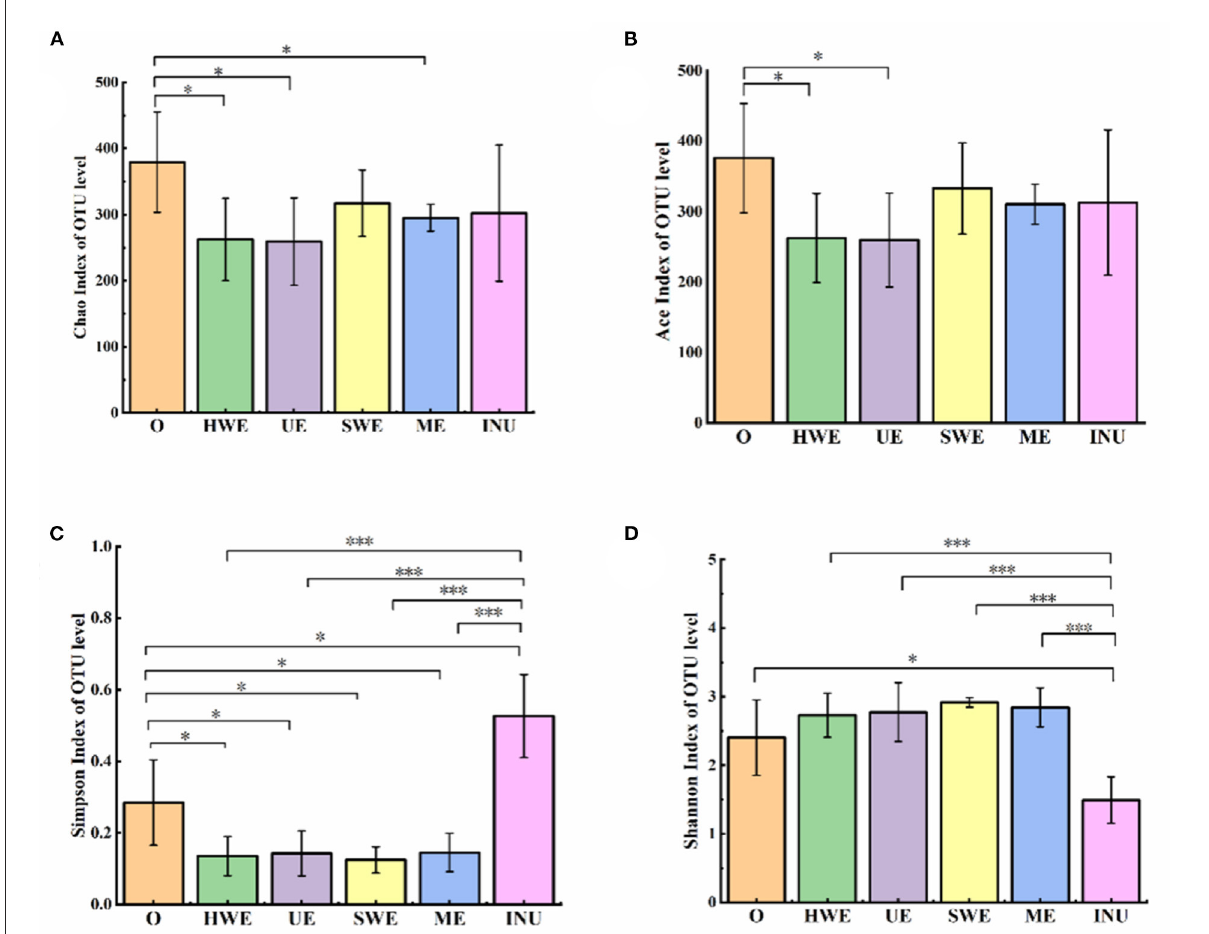
FIGURE4 (A-D) Species richness and diversity analysis ( n = 5). O stands for blank control group. HWE, UE, SWE, and ME stand for dietary fiber extracted with hot water, ultrasonic assisted, subcritical water, and microwave assisted methods, respectively. INU stands for inulin. * P < 0.05, *** P <